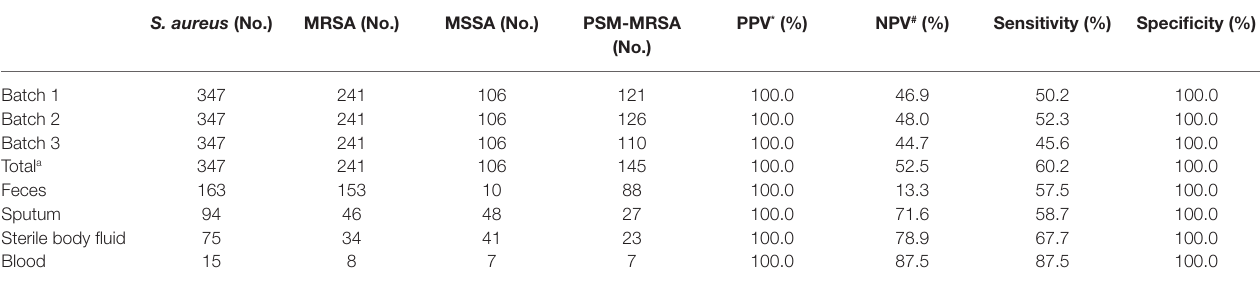
TABLE 1 | Statistics analysis of different groups of S. aureus strains. S. aureus